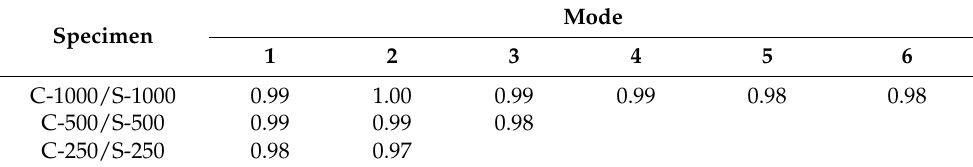
Table 12. Ratio of identified frequencies for different